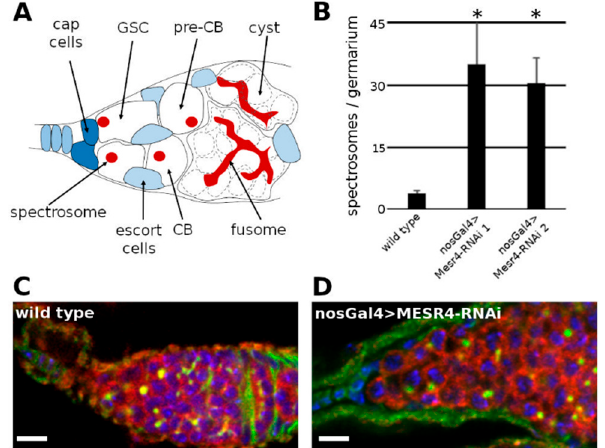
Figure 1. MESR4 cell-autonomously promotes germ cell differentiation. ( A ) Schematic representation of a Drosophila niche where the germ cells (white) are surrounded by somatic cells (blue). The germline stem cells (GSCs) reside in the anterior tip of the niche in a specific somatic microenvironment, the stem cell niche, maintained by somatic cells. The GSCs divide continuously and give rise to a self-renewing daughter stem cell and a differentiating daughter cell, called pre-cystoblast (pre-CB). The pre-CB starts to express differentiation factors and becomes cystoblast (CB). The CB undergoes incomplete cell divisions to give rise to 2, 4, 8 and 16-cell cysts. The GSCs, pre-CBs and CBs contain a dot like structure called spectrosome (red) and the more differentiated cysts contain a branched fusome (red). ( B ) Quantification of single, spectrosome containing cells in wild type and MESR4 silenced niches using two different RNAi lines (35.0 ± 10.2 in MESR4- RNAi line 1, n = 24 and 30.5 ± 6.1 in MESR4- RNAi line 2 n = 24 compared to 3.9 ± 0.8 in wild type control, n = 24). Data are mean ± s.d.; t -test, * p < 0.05. (C,D) Immunostaining of wild type ( C ) and nosGal4 > MESR4 - RNAi ( D ) niche with germ cell tumor. Spectrosomes and fusomes are labelled with HTS (green), germ cells are labelled for Vasa (red); DAPI is blue. Scale bars are 10 µm.